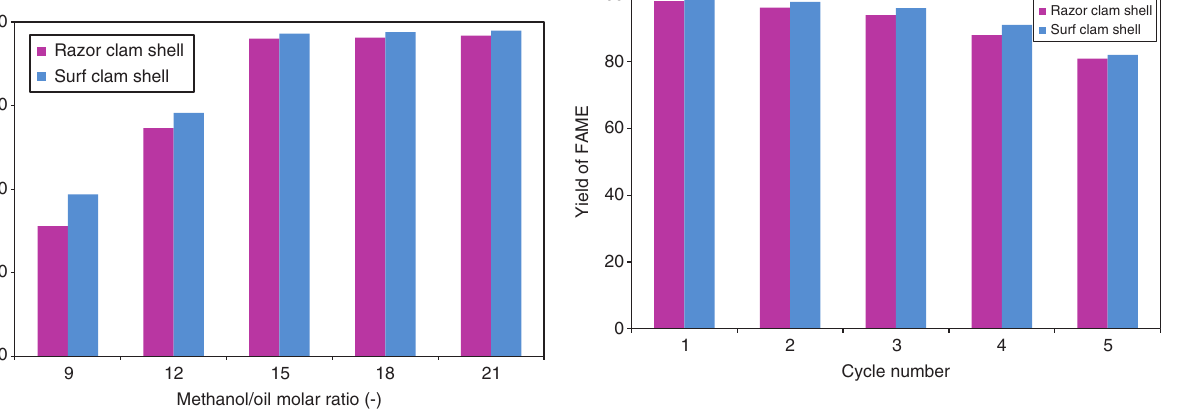
Figure 9: Effect of methanol/oil molar ratio on % yield of fatty acid methyl ester (FAME) (catalyst bed length 250 mm, residence time 1.5 h, and reaction temperature 60 ° C).